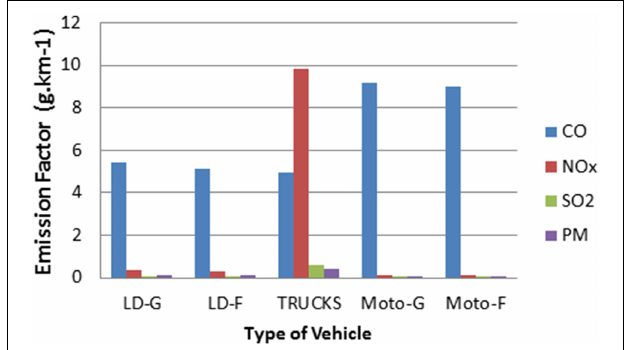
Table 5 | Vehicle types and proportional use of fuels.